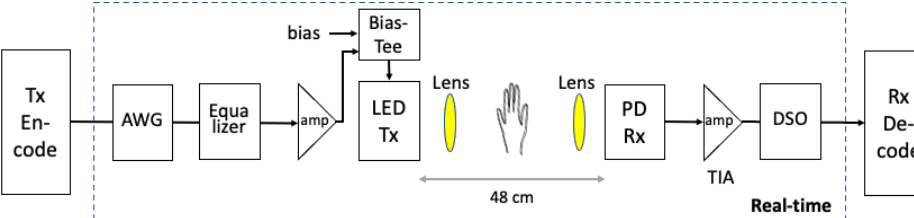
Figure 4. VLC for HAR system block